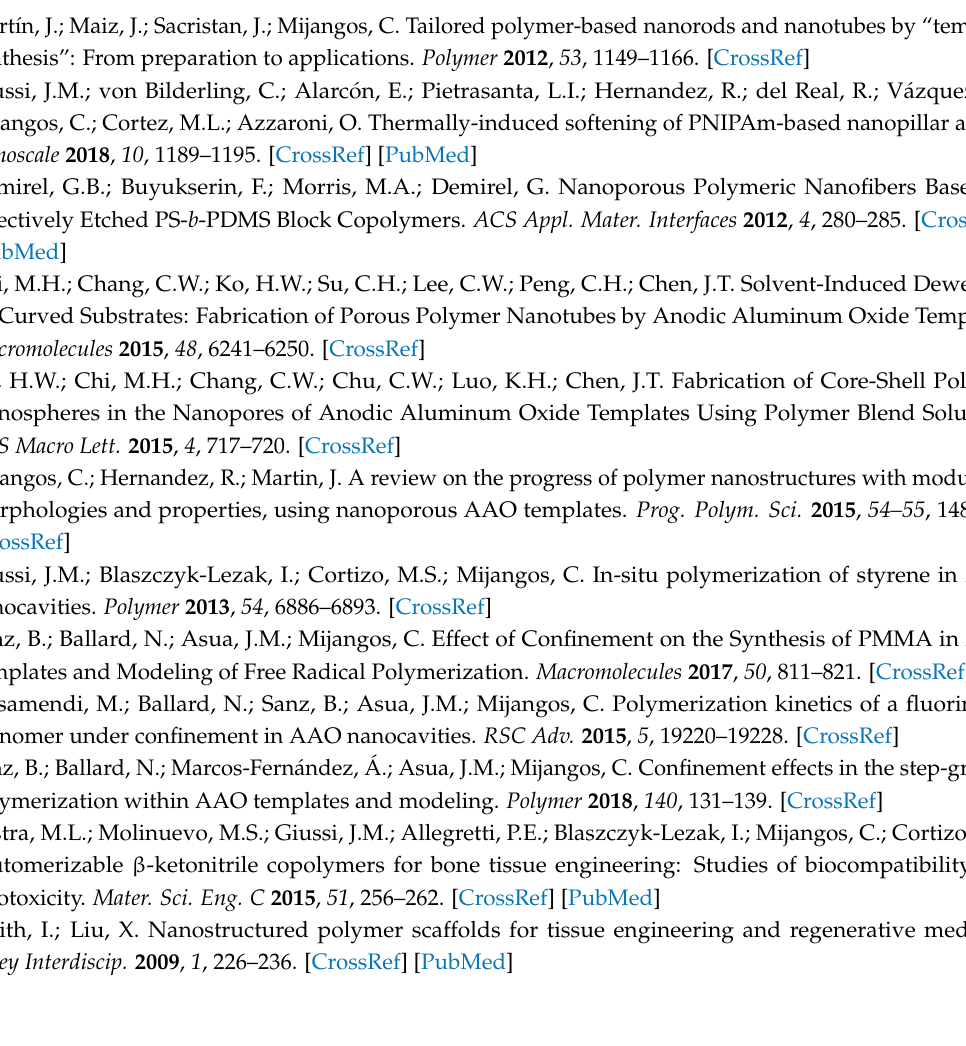
Figure S2: Extended H NMR spectra for homo- and copolymers obtained under bulk condition with assignments of resonance